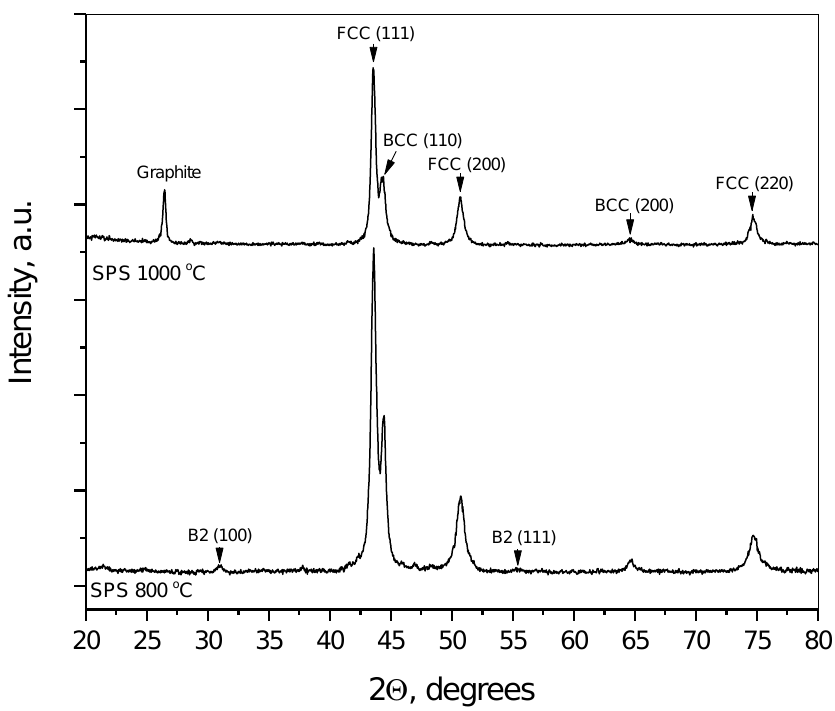
Figure 4. Di ff raction patterns of materials SPS-consolidated at 800 ◦ C and 1000 ◦ C (indicated). Figure 4. Diffraction patterns of materials SPS-consolidated at 800 °C and 1000 °C (indicated).